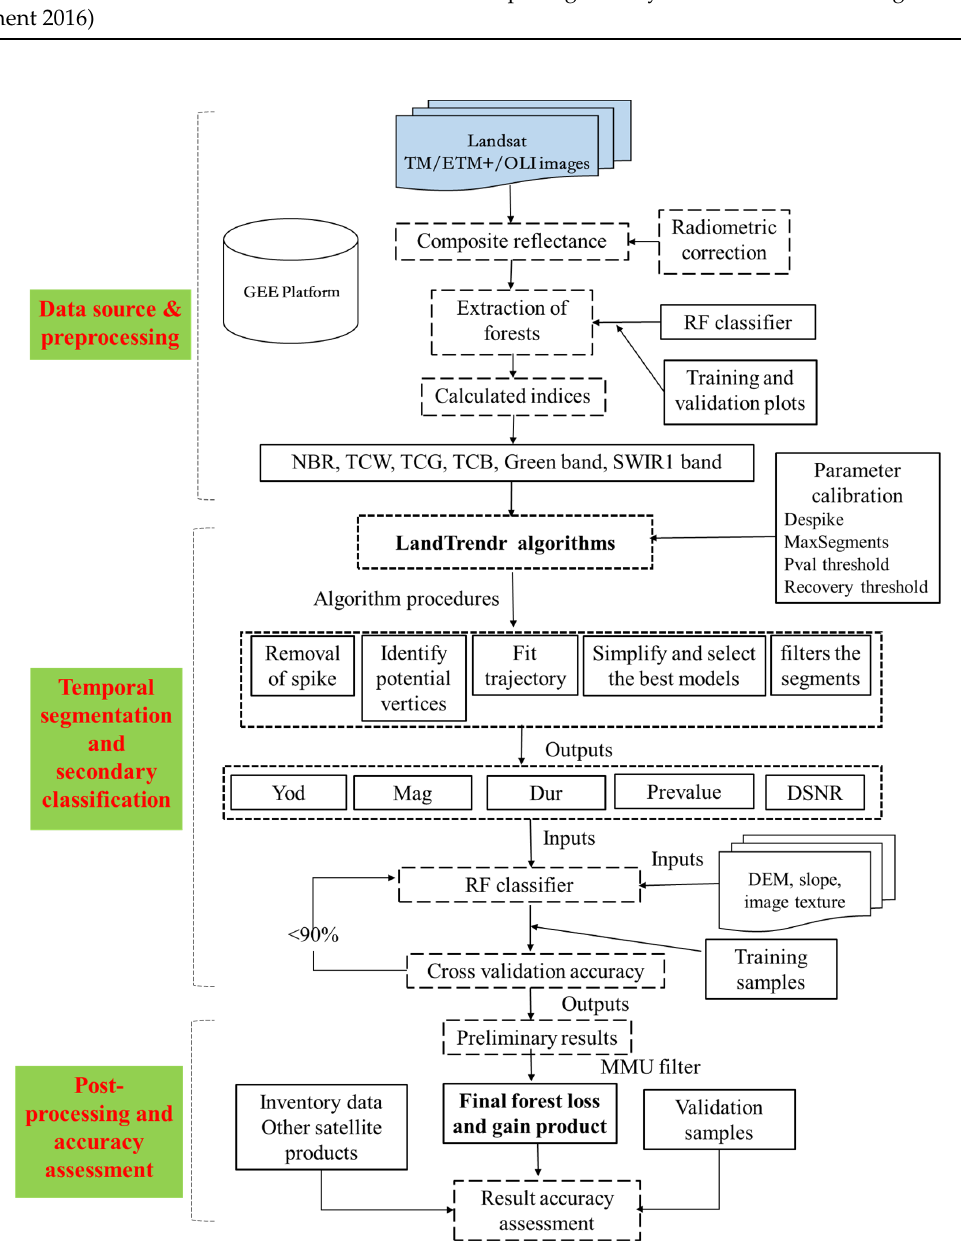
Figure 3. The work flow for forest loss and gain detections by integrating the LandTrendr algorithm with the Random Forest machine-learning method. Note: NBR, TCB, TCG, and TCW are vegetation indices. Green: green band (Band2); SWRI1: short-wavelength infrared band 1 (Band5); RF: Random Forest; Yod (year of detection), Mag (magnitude), Dur (Duration), Prevalue, and Dsnr (Detail Signal Noise Ratio) were the outputs from LandTrendr.